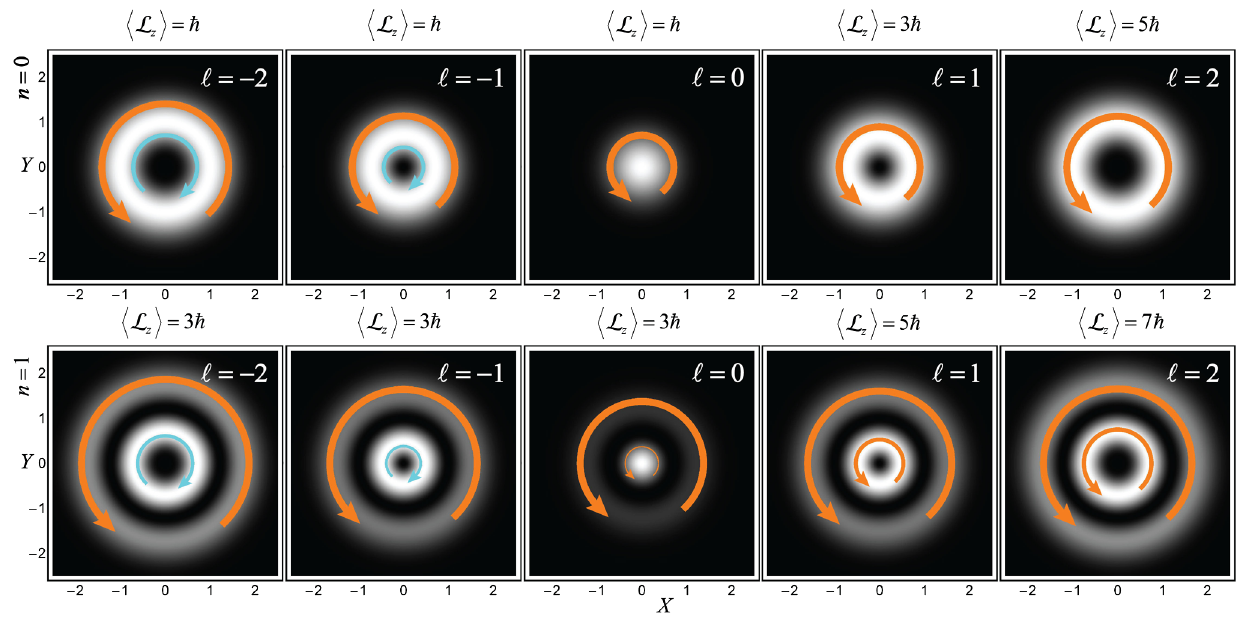
FIG. 5. Transverse probability-density distributions and azimuthal currents, Eqs. (30), for the Landau LG modes (27) with different OAM quantum numbers ‘ in a magnetic field with (cid:8) ¼ 1 . While the probability-density distributions have the same form as for the LG beams in free space (see Fig. 3), the current distributions differ drastically due to the strong vector-potential contribution. Here, the integral azimuthal current and kinetic OAM (33) are always positive, independent of the sign of ‘ . The dimensionless coordinates X ¼ x=w and Y ¼ y=w are m m